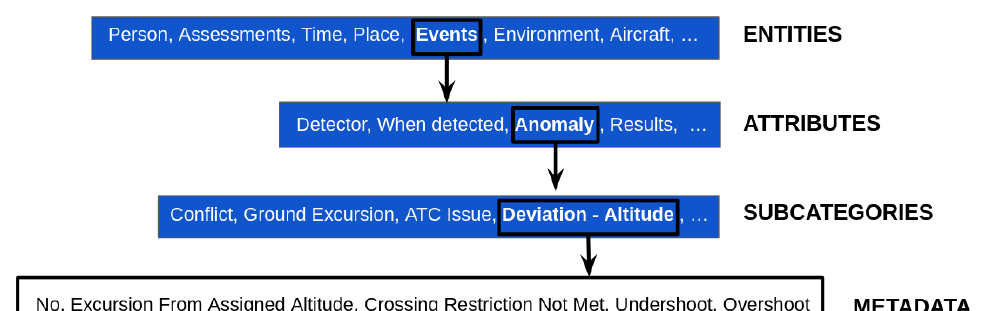
Figure 2. ASRS taxonomy architecture: the case of the “Deviation—Altitude” anomaly for the “Events”